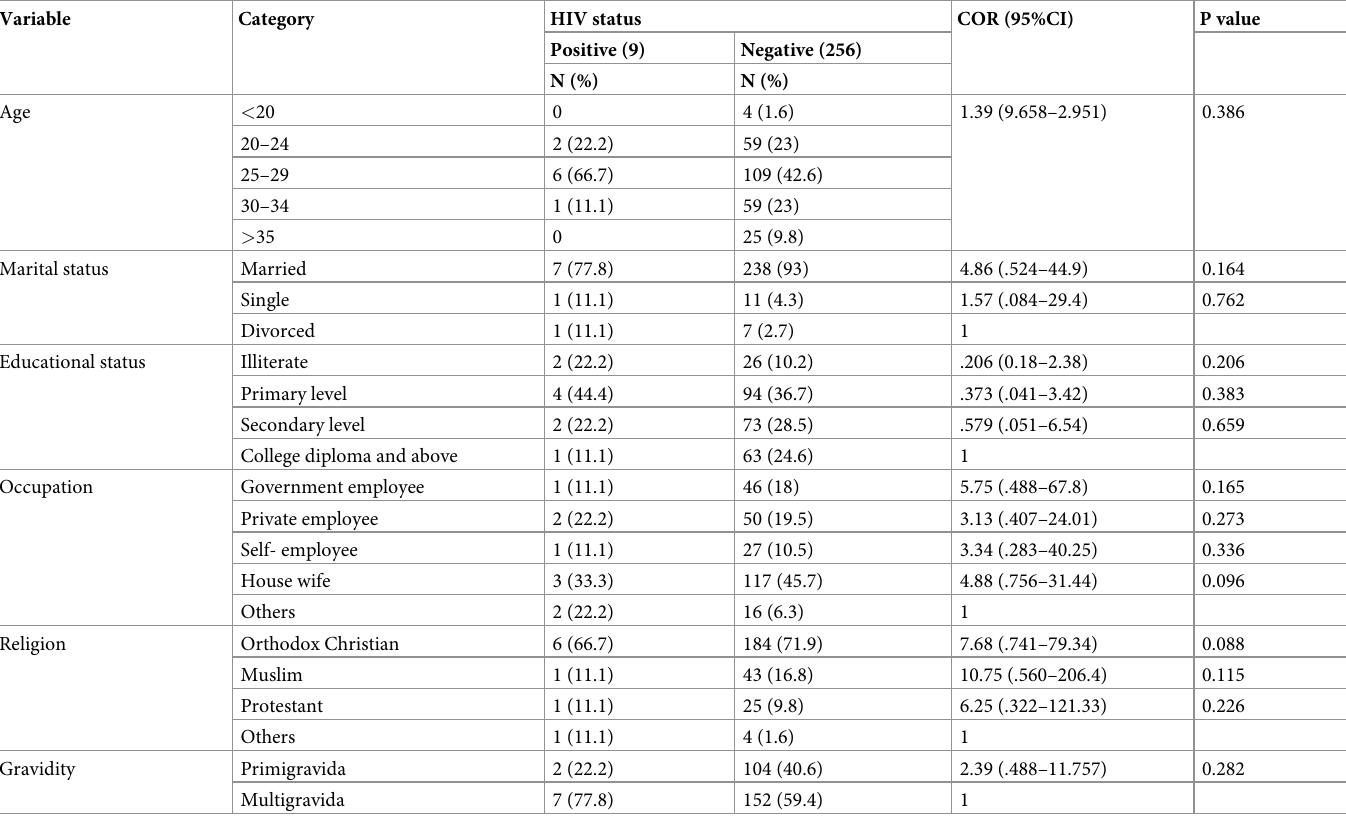
Table 2. Socio-demographic characteristics and HIV co-infection among HBsAg positive delivering mothers in governmental hospitals in Addis Ababa, 2019–